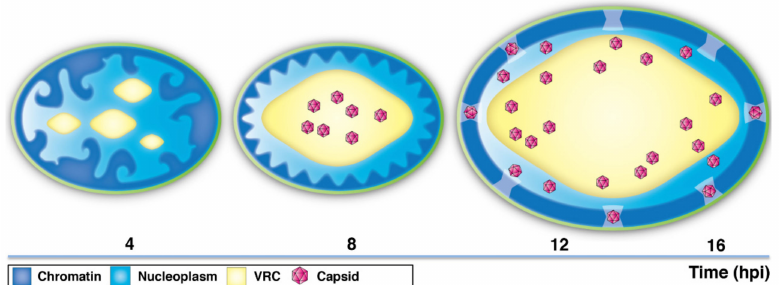
Figure 6. A schematic presentation of the time-dependent changes in chromatin architecture and distribution of HSV-1 capsids. At early infection (~4 hpi), the viral replication compartments (VRCs) appear as distinct nuclear foci. Later in infection (~8 hpi), small VRSs undergo fusion and expansion into a large, globular VRC. The chromatin is marginalized and compacted close to the NE. The capsids are mostly located in the central regions of the nucleus. At late infection (12–16 hpi), the enlargement of the nucleus and the VRC is accompanied by smoothening of the chromatin layer and increase in the interchromatin space in the nuclear periphery. The capsids travel towards the peripheral nucleoplasm and the